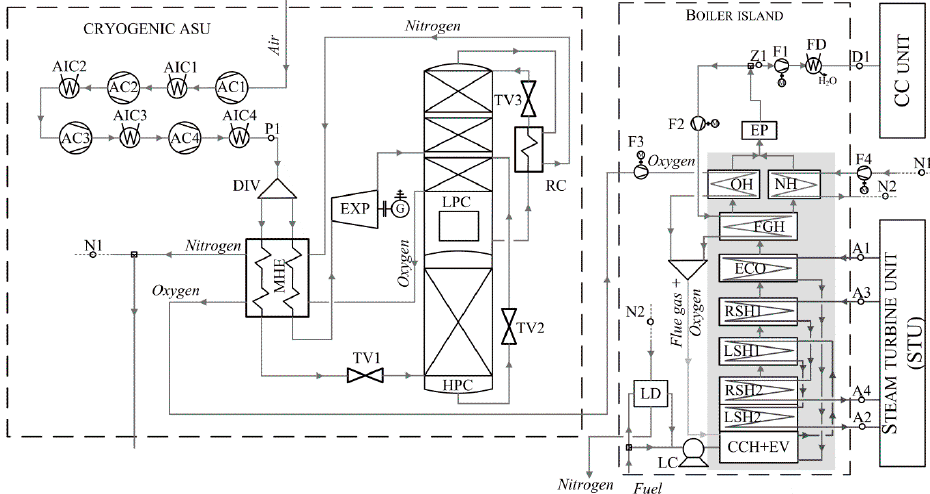
Figure 4. Scheme of the fluidized-bed boiler integrated with a cryogenic ASU (AC–air compressor; AIC–air intercooler; CCH–combustion chamber; DIV–division valve; ECO–economizer; EP–electrostatic precipitator; EV–evaporator; EXP–expander; F–fan; FGH–flue gas heater; HPC–high-pressure column; LC–lignite crusher; LD–lignite dryer; LPC–low-pressure column; LSH–live steam heater; MHE–multi-stream heat exchanger; NH–nitrogen heater; OH–oxygen heater; RC–regenerative cooler; RSH–reheated steam heater; TV–throttle valve).